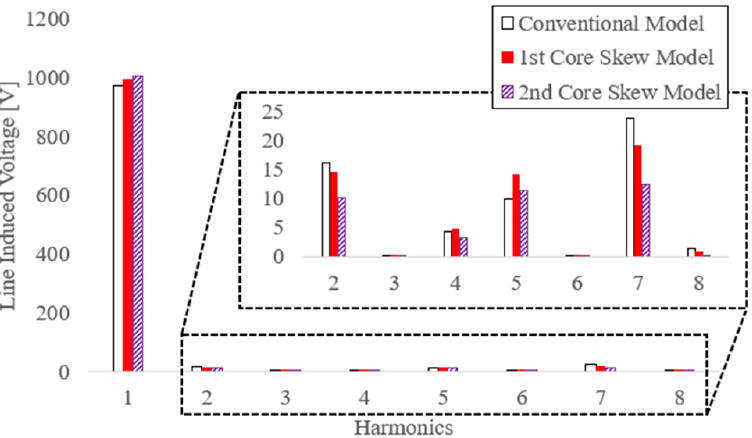
Figure 14. 15,660 rpm no-load line-induced voltage spectra.